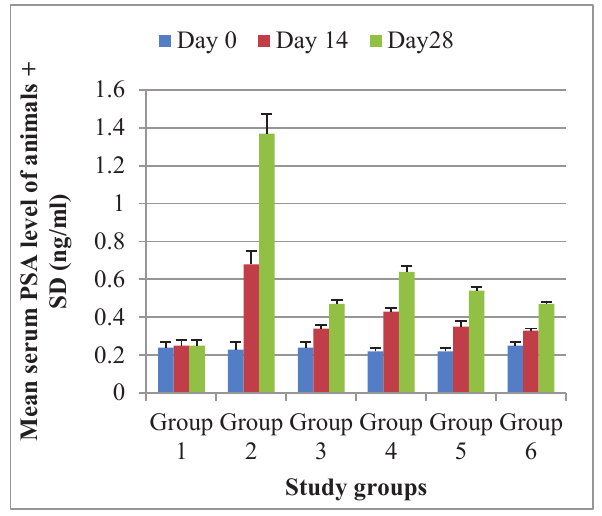
Fig-2: Cluster bar diagram presenting mean serum PSA levels for six study groups (error bars presenting standard